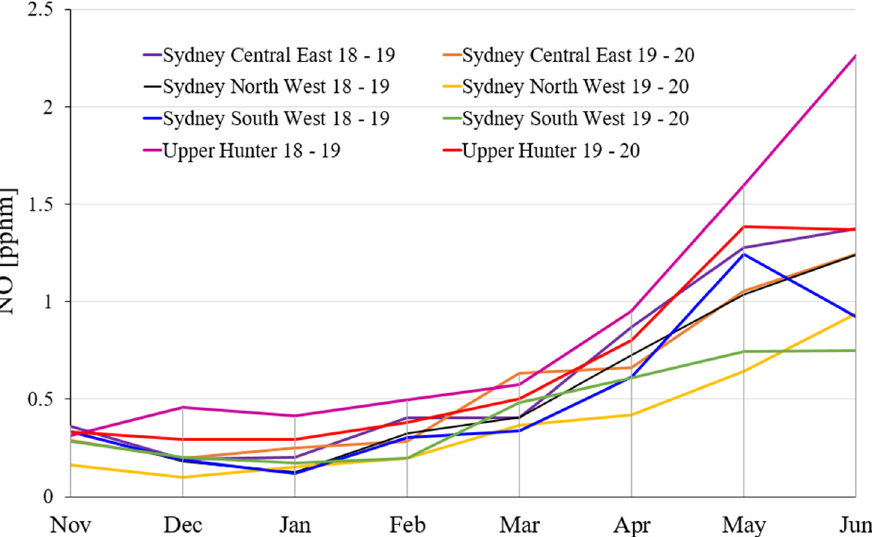
Figure 6. The monthly average NO emission in Sydney Central East, North West, South West, and